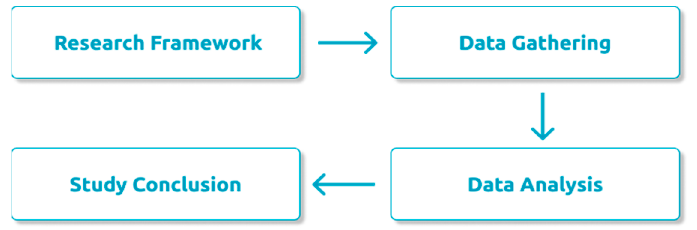
Figure 2. Method of the